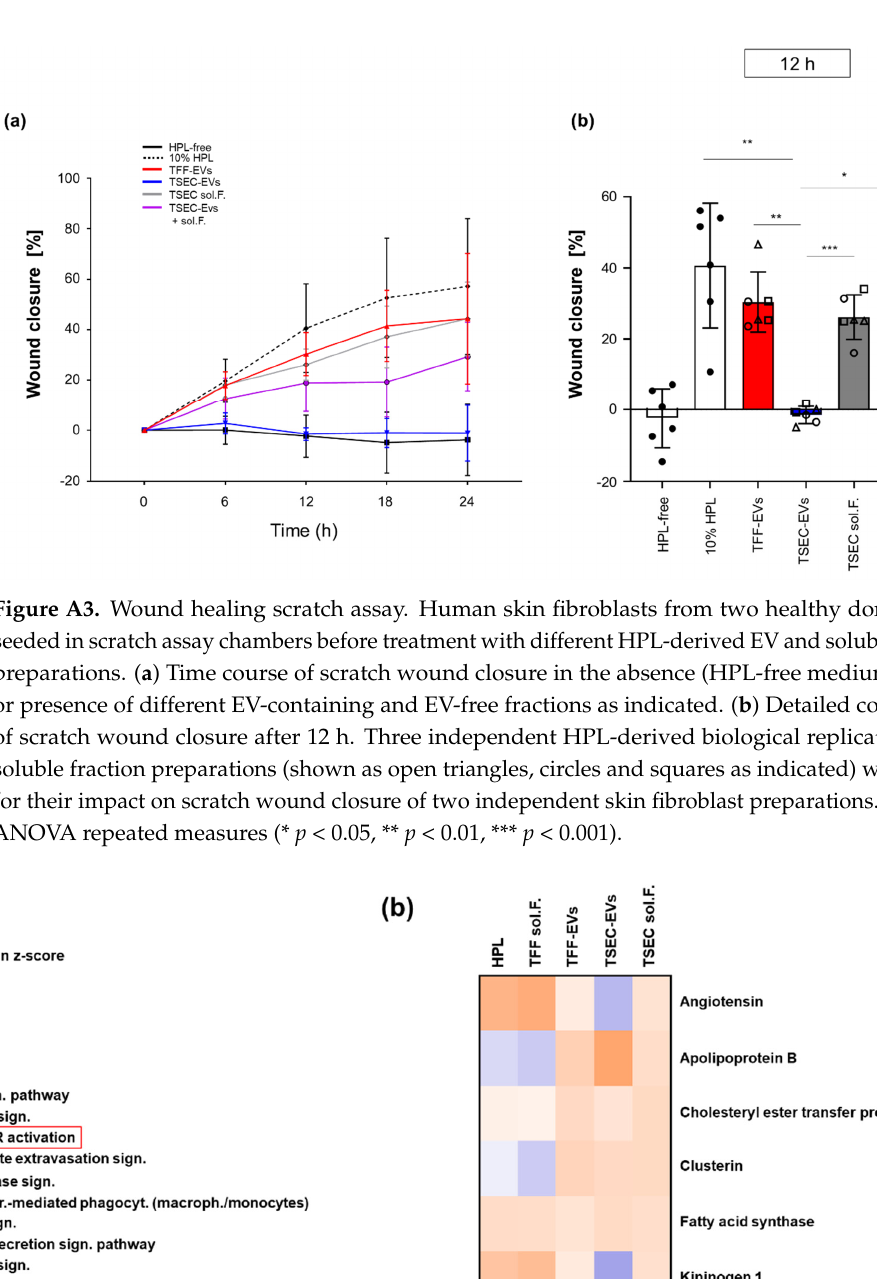
Figure A2. Loss of angiogenic potential of HPL-EVs after size-exclusion chromatography. Total length of the endothelial networks in the absence (white bar, negative control; grey bar, positive control) or presence of HPL-derived TFF-EVs and TSEC-EVs at EV:cell ratios of 100,000, 10,000 and 1000:1. TFF-EVs at the ratio of 100,000:1 were capable of inducing endothelial-cell network for- mation, whereas TSEC-EVs were not able to induce such effect at any given concentration. Mean ± SD of three independent experiments performed in quadruplicate. One-way ANOVA/Tukey, **** p ≤ 0.0001, * p ≤ 0.05.